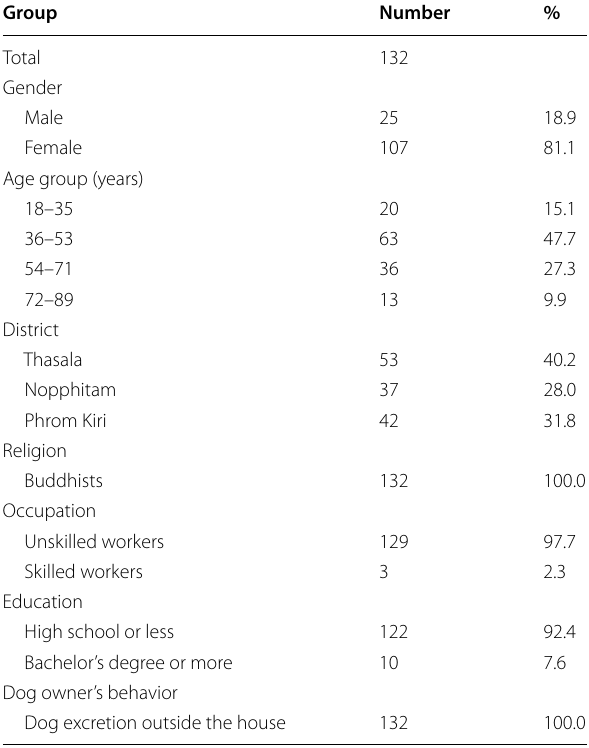
Table 1 Sociodemographic characteristics of 132 dog owners in